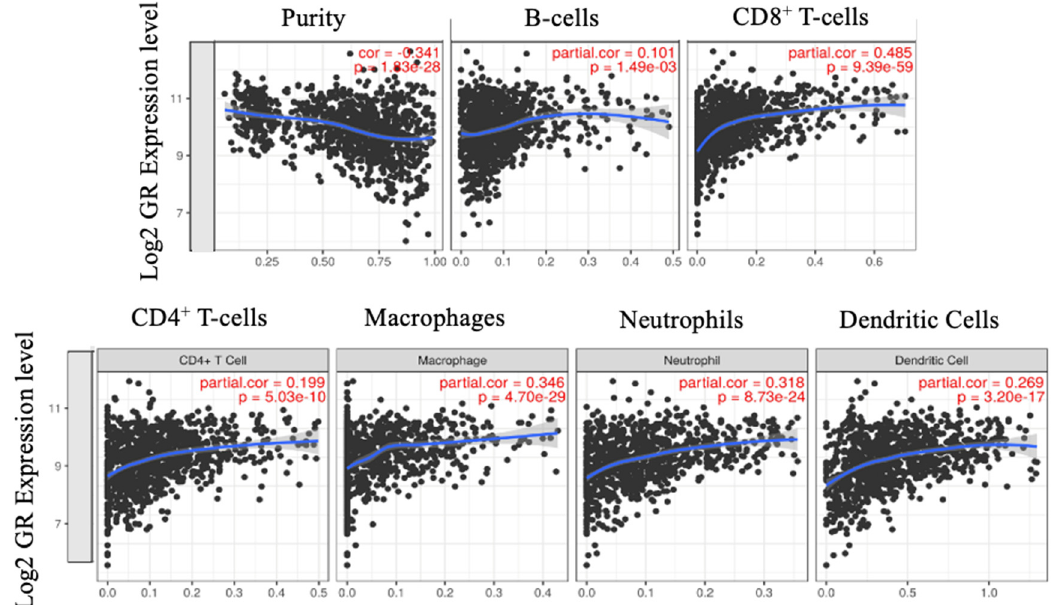
Figure 3. Spearman rho correlation was used to assess correlation between GR expression and immune cells. Correlation is quantified as weak (absolute value < 0.3), moderate (absolute value between 0.3 and 0.5) and strong (absolute value > 0.5) in either direction. Moderate correlation observed between CD8 + T-cells and macrophages and GR expression in breast cancer using TIMER. This moderate positive correlation between GR expression and macrophages was not, however, validated using other deconvolution algorithms.